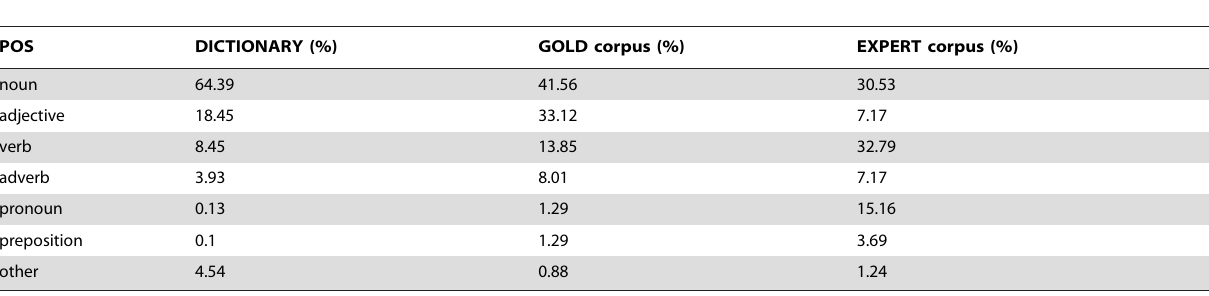
Table 6. Relative distribution of POS in the IceMorph dictionary, GOLD, and EXPERT.